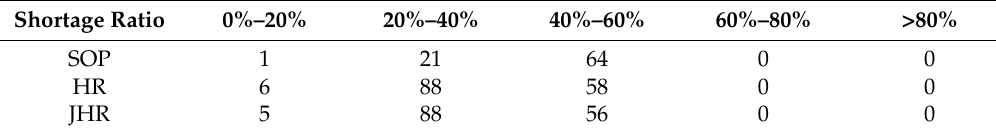
Table 5. Number of different water shortage in ( w , xd ) case.